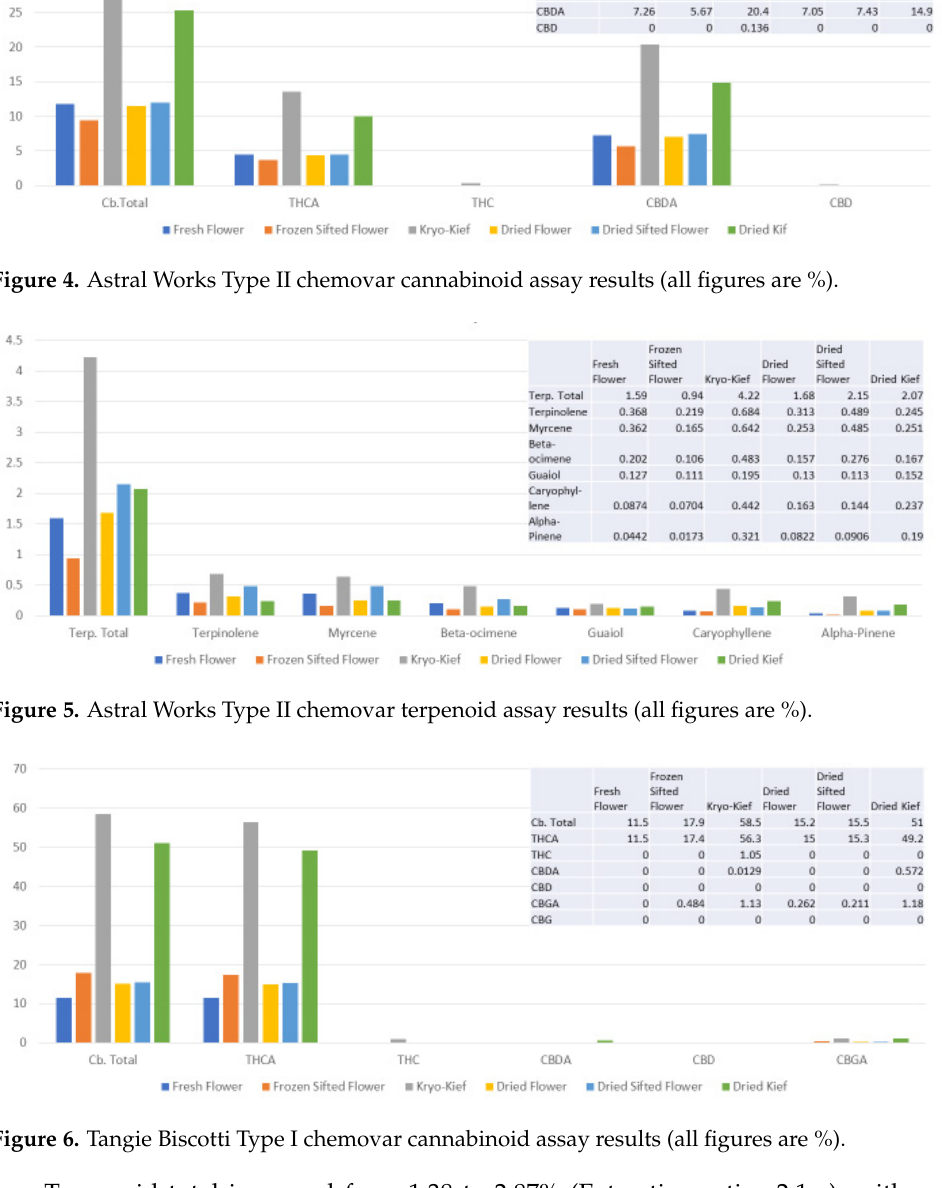
Figure 7. Tangie Biscotti Type I chemovar terpenoid assay results (all figures are